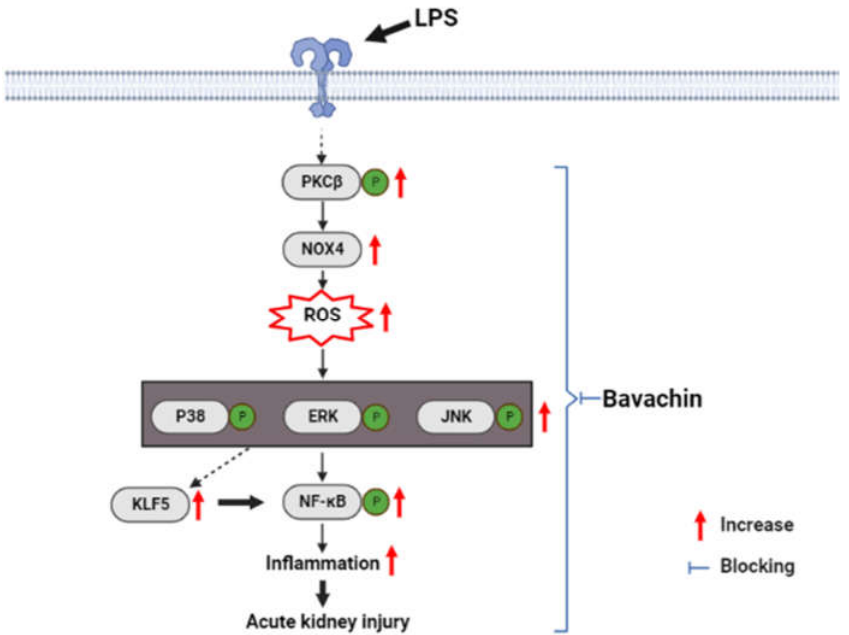
Figure 7. Schematic of the mechanism by which bavachin ameliorated acute kidney injury induced by LPS through PKCβ/MAPK/KLF5 signaling.